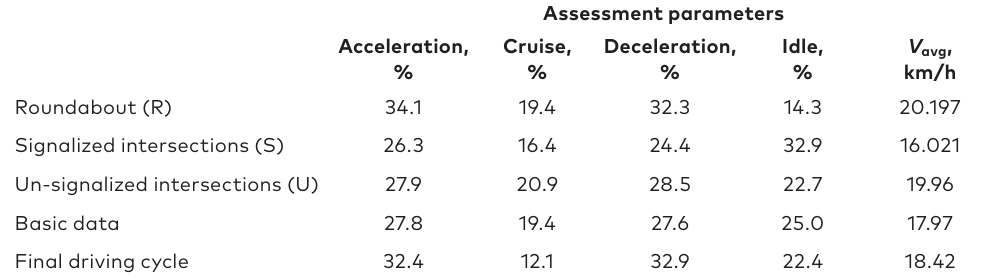
Table 6. Comparison of assessment parameters Assessment